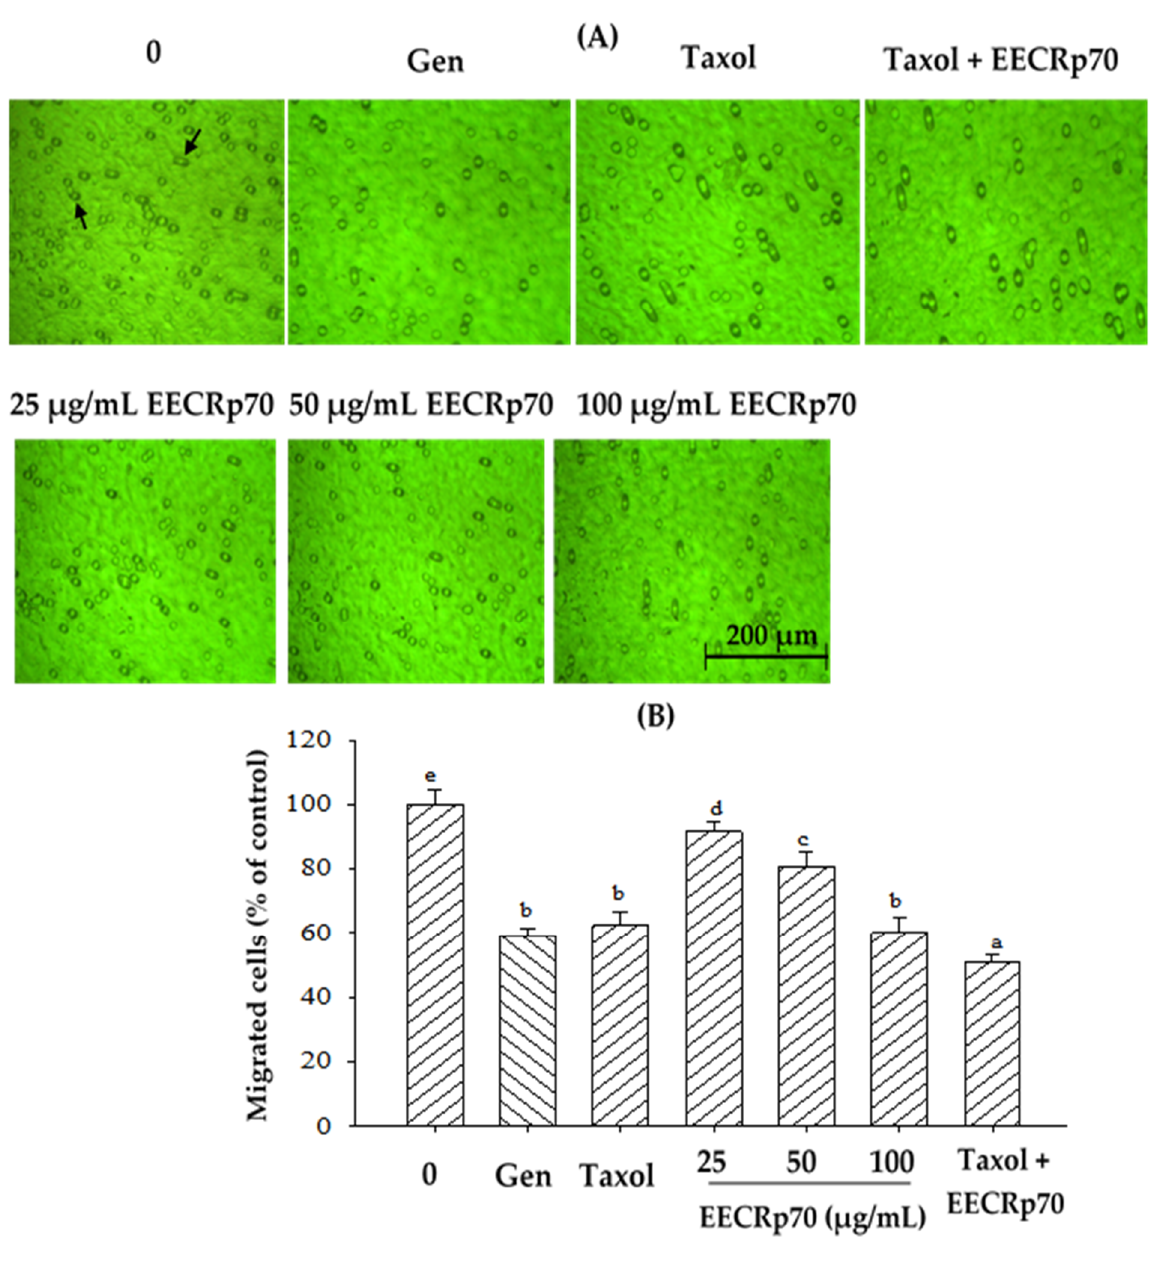
Figure 8. Effects of EECRp70 on a transwell migration assay in SCC25 cells. ( A ) Photomicrographs and ( B ) percentages of migrated cells. Cells were incubated with 25 µM genistein, 10 nM taxol, 25–100 µg/mL EECRp70, and 10 nM taxol + 25 µg/mL EECRp70 for 24 h. Photomicrographs were obtained using an Inverted Fluorescence Microscope BestScope-7000B (×200 magnification and scale bar 200 µm). For each replicate, the cancer cells in six randomly selected fields were determined and counted averaged. The Arrowhead indicated the migrated cells. Values (mean ± SD) not labeled with a common letter are significantly different ( p < 0.05).